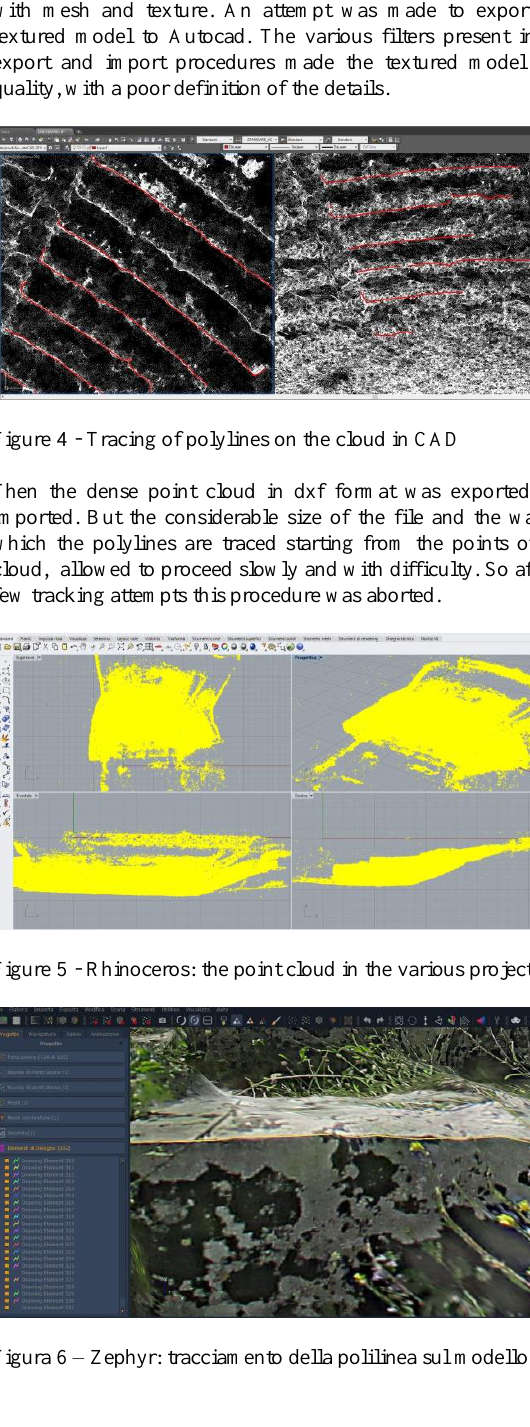
Figure 8 – Palazzolo Acreide, graphic interpretation of